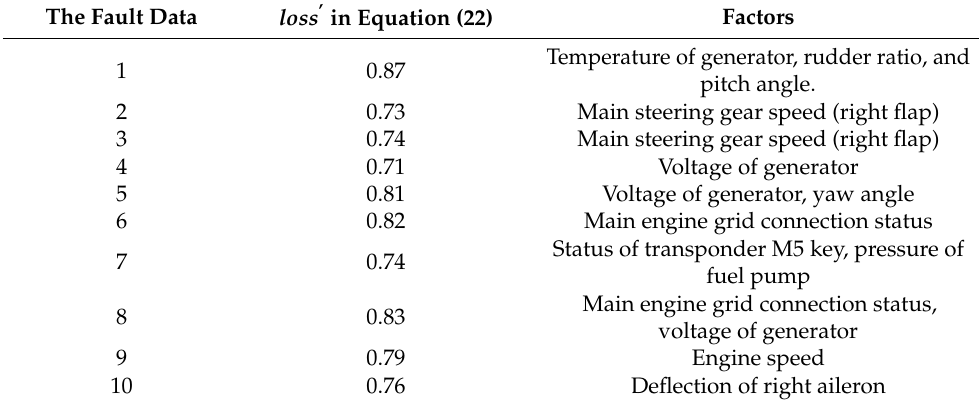
Table 9. More results of the experiment.